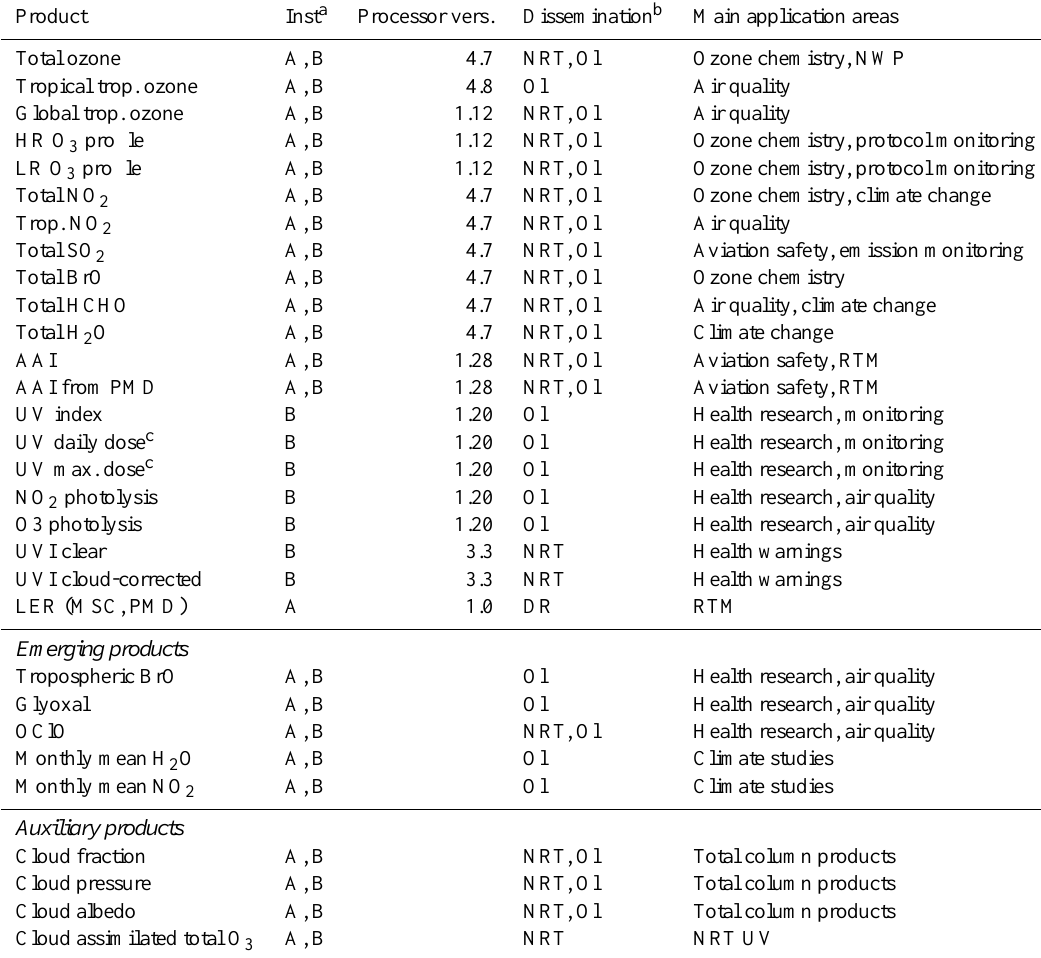
Table 2. O3M SAF GOME-2 L2 products available to users, a summary table showing additional information. HR O 3 profile refers to high spatial resolution ozone profile product, whereas LR O 3 profile refers to low spatial resolution ozone profile